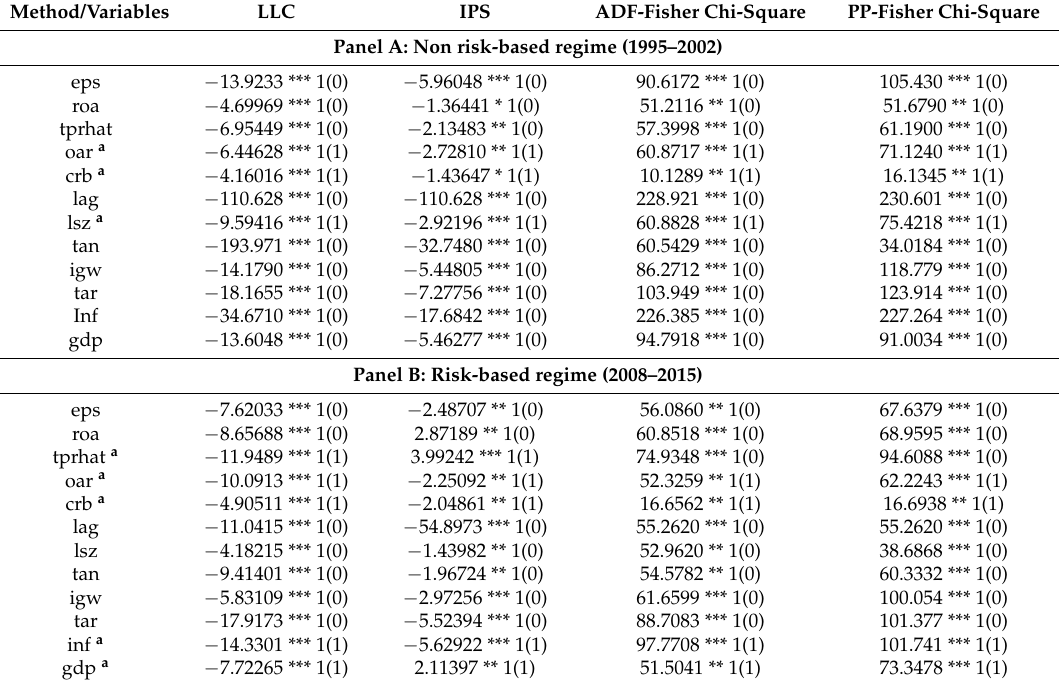
Table 4. Panel unit root tests for 15 listed insurers in Nigeria, 1995–2002 and